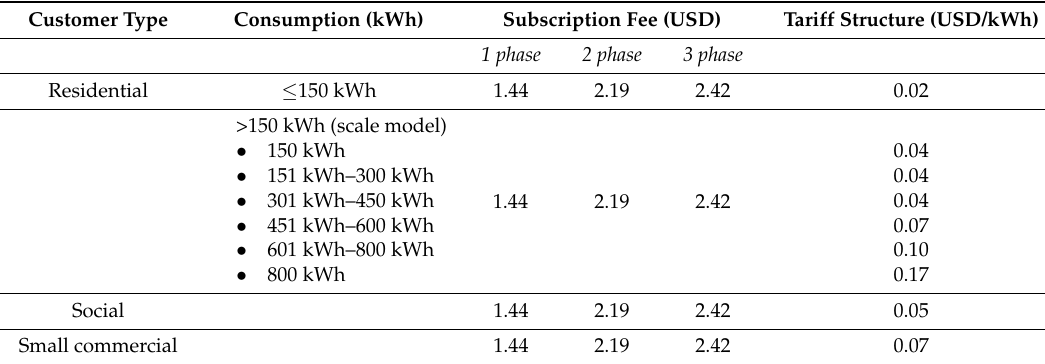
Table 1. Electricity tariffs for different customer types. Data source: N.V. EBS [20].